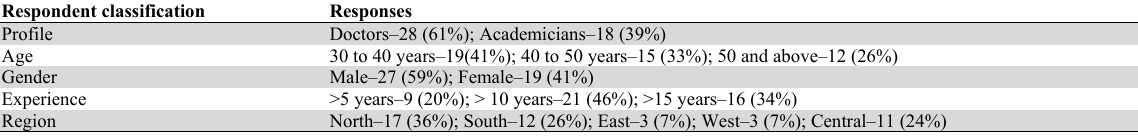
Profile of the respondents for modularity survey (N= 46) Respondent classification